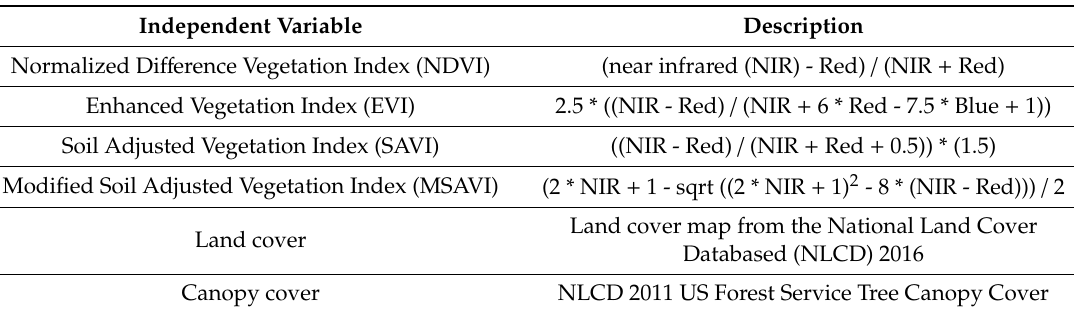
Table 2. Metrics derived from Landsat 8 Operational Land Imager (OLI) and National Land Cover